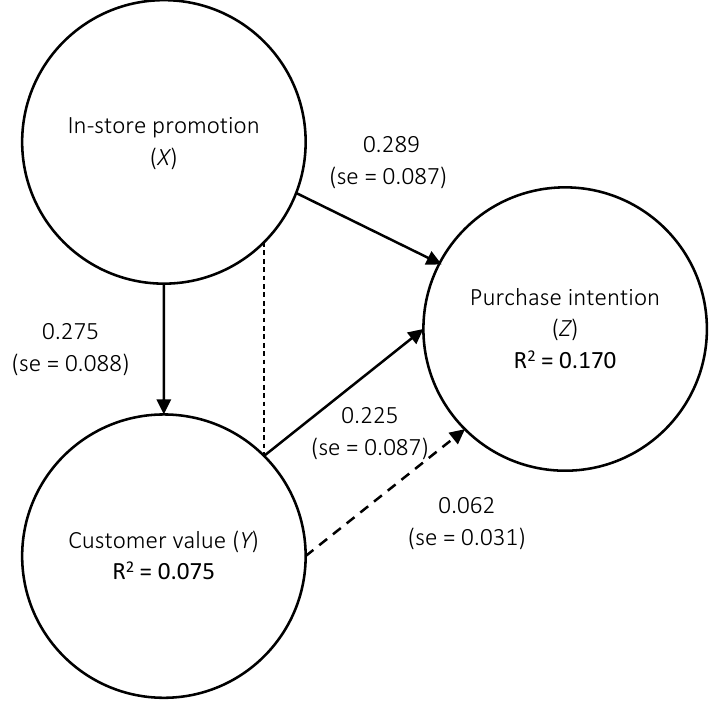
Figure 2. Influence model of in-store promotion on customer value and its influence on purchase